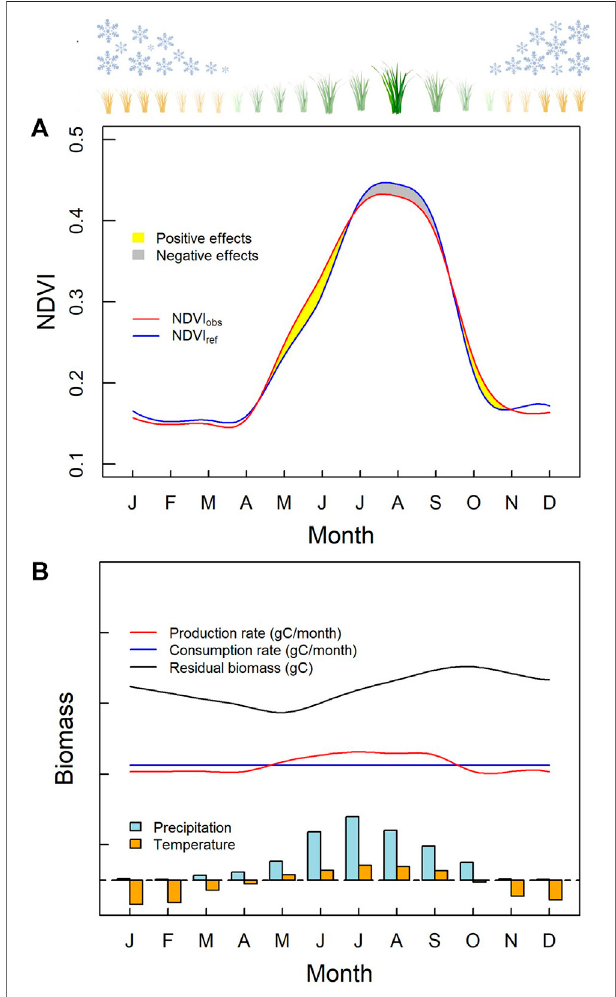
FIGURE 3 | Seasonal grazing effects on vegetation. (A) Seasonality of grazing effects on NDVI; (B) Seasonality of grazing effects on biomass. The referenceNDVI(NDVI ref )wasestimatedbydeductinggrazingeffectsusingthe NDVI * diff ∼ ( LS − LS 0 ) relationship from the observed NDVI (NDVI obs ).